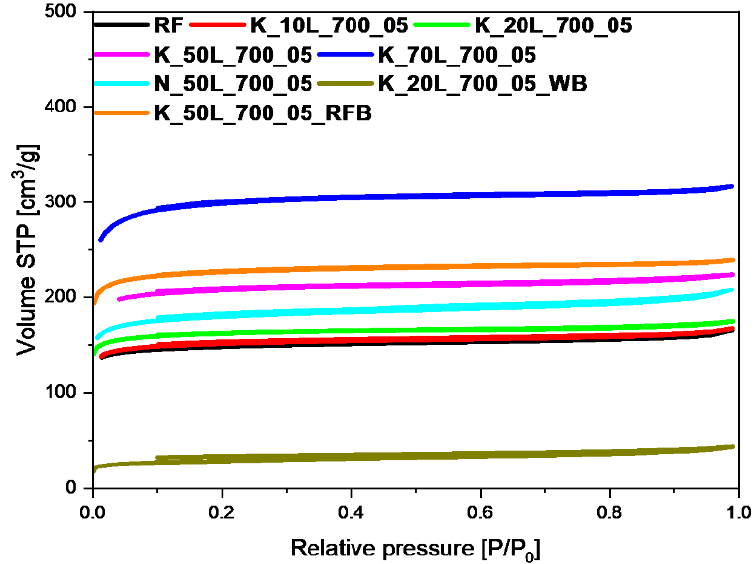
Figure 3. Nitrogen adsorption-desorption isotherms of reference material (RF), and samples activated using solution-based method with different KOH content.